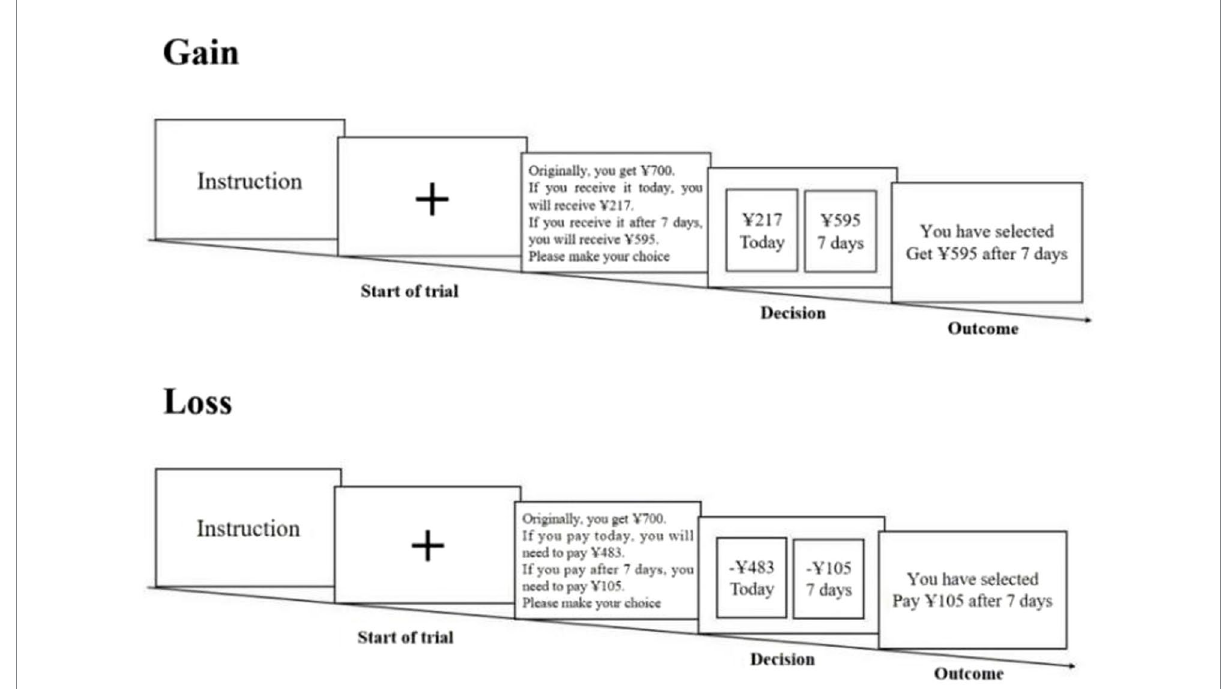
FIGURE 1 Experimental flow chart in the gain-loss